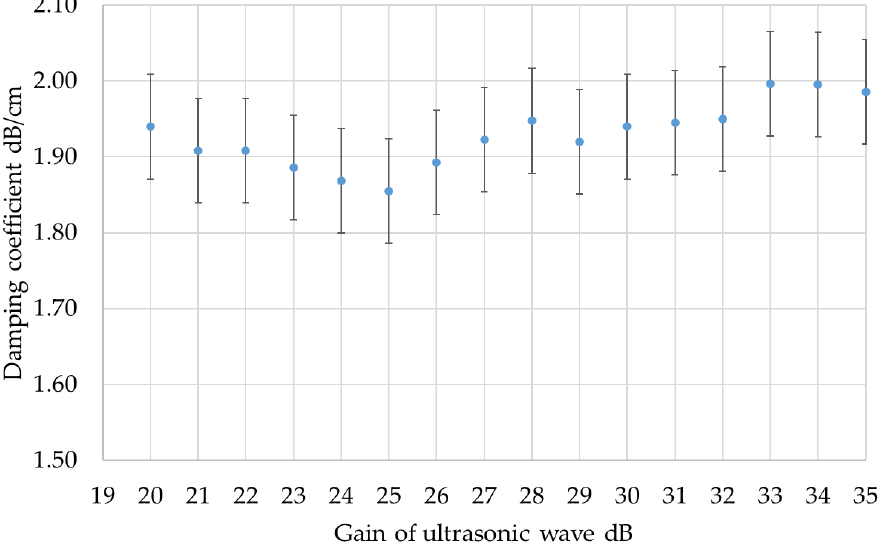
Figure 3. Dependence of the gain of the wave pulse on the attenuation of an ultrasonic wave in a material.